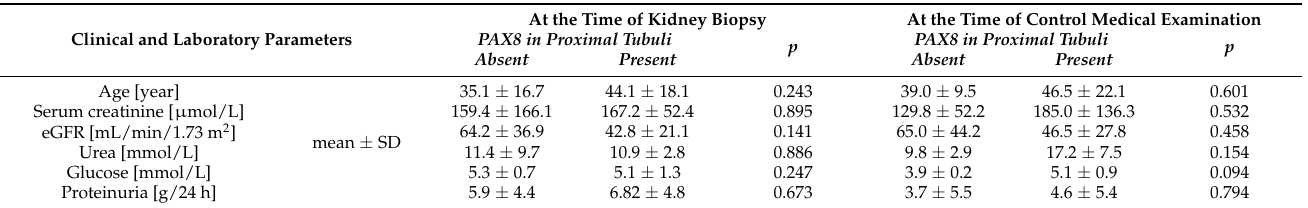
Figure 5. Relationship of PAX8 nuclear expression in the proximal tubuli with interstitial fibrosis and tubular atrophy. ( A ) Distribution of the patients according to positive PAX8 expression in proximal tubuli and stratified by the presence or absence of interstitial renal fibrosis (IRF). ( B ) Distribution of the patients according to the positive PAX8 expression in proximal tubuli and stratified by the presence and absence of tubular atrophy (TA). Table 1. Clinical and laboratory parameters of 20 patients clinically presented with nephrotic syndrome.